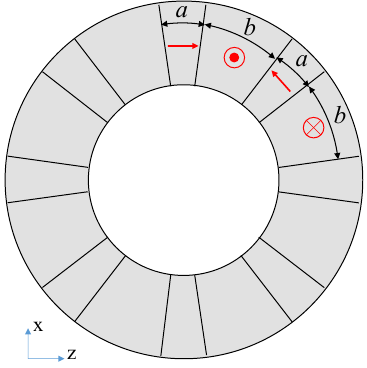
Figure 6. Circular Halbach array magnetic